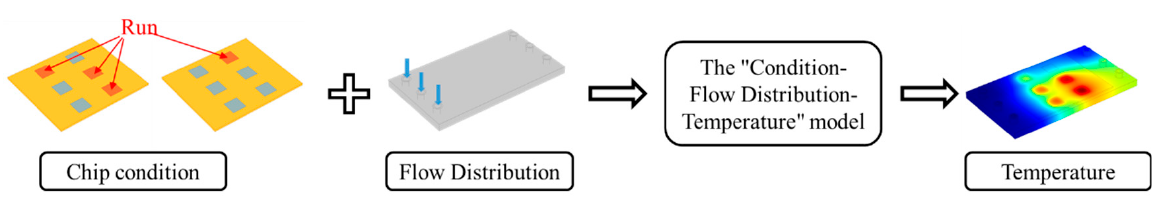
Figure 6. The legend of “condition–flow distribution–temperature” model.